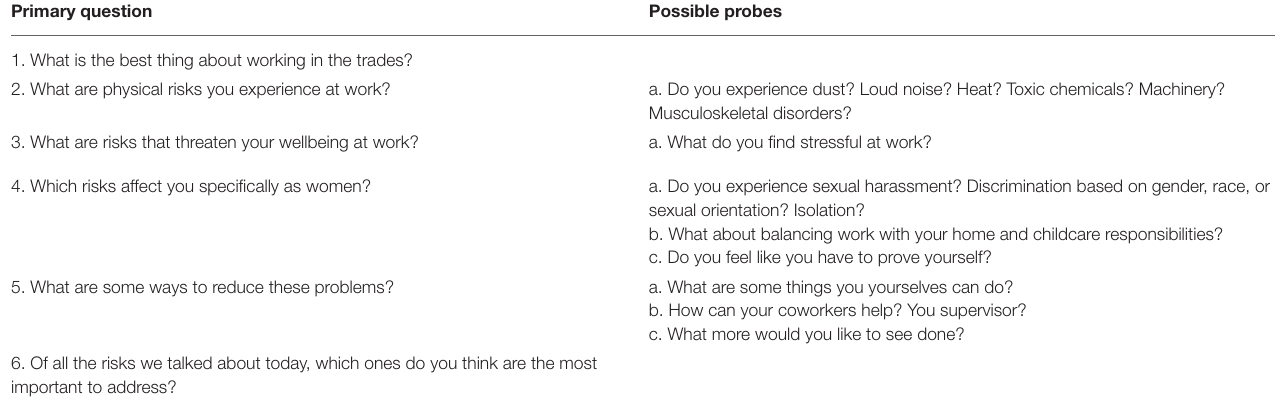
TABLE 1 | Focus Group Facilitation